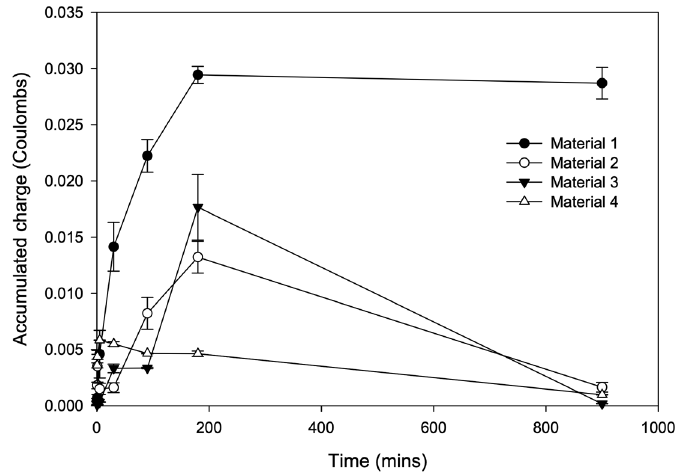
Figure 6. Charge accumulation with materials 1, 2, 3 and 4 (8 weeks’ operation) after different open-circuit time periods.